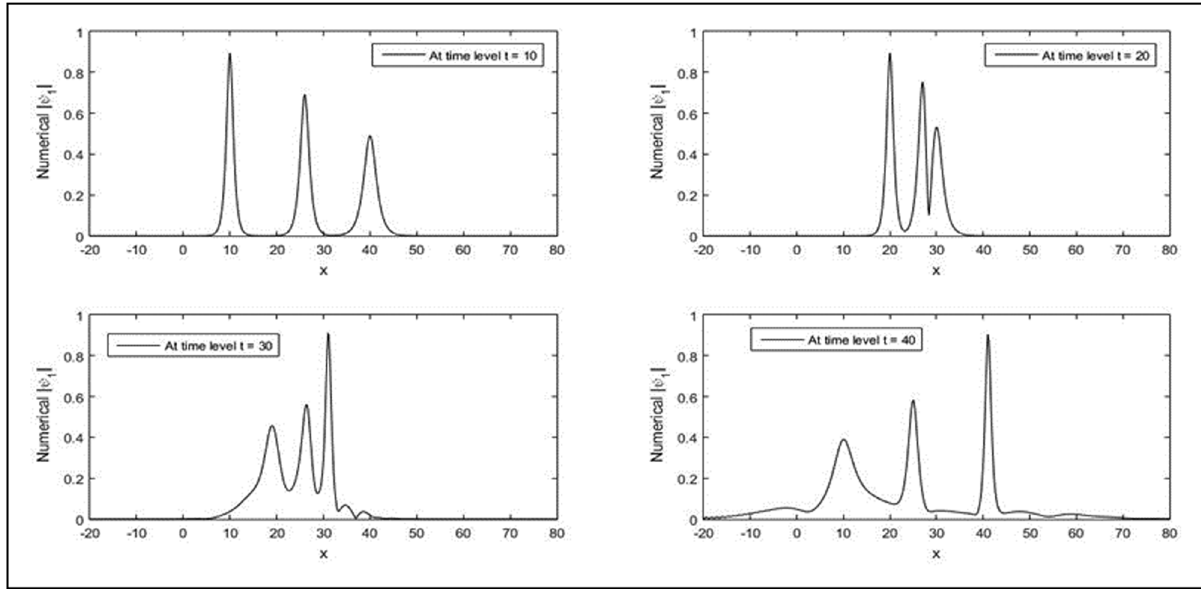
Figure 11: Interaction of three solitons for fi rst - wave amplitude for